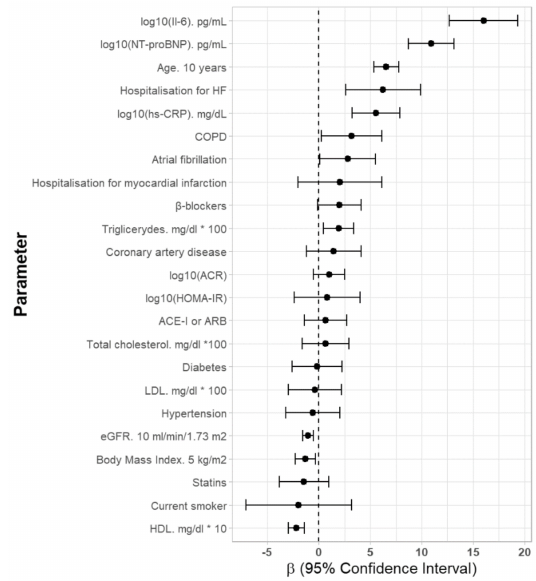
Figure 1. Univariate parameters associated with serum CA125 concentrations in older